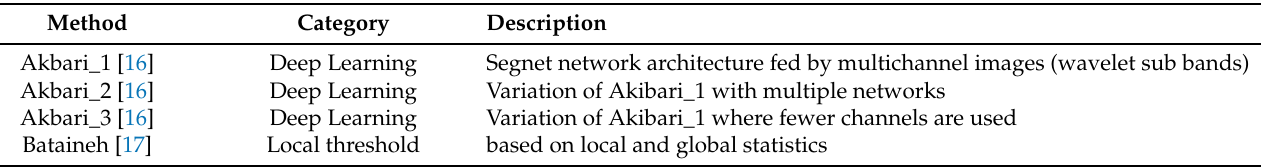
Table 1. Tested binarization algorithms—Part